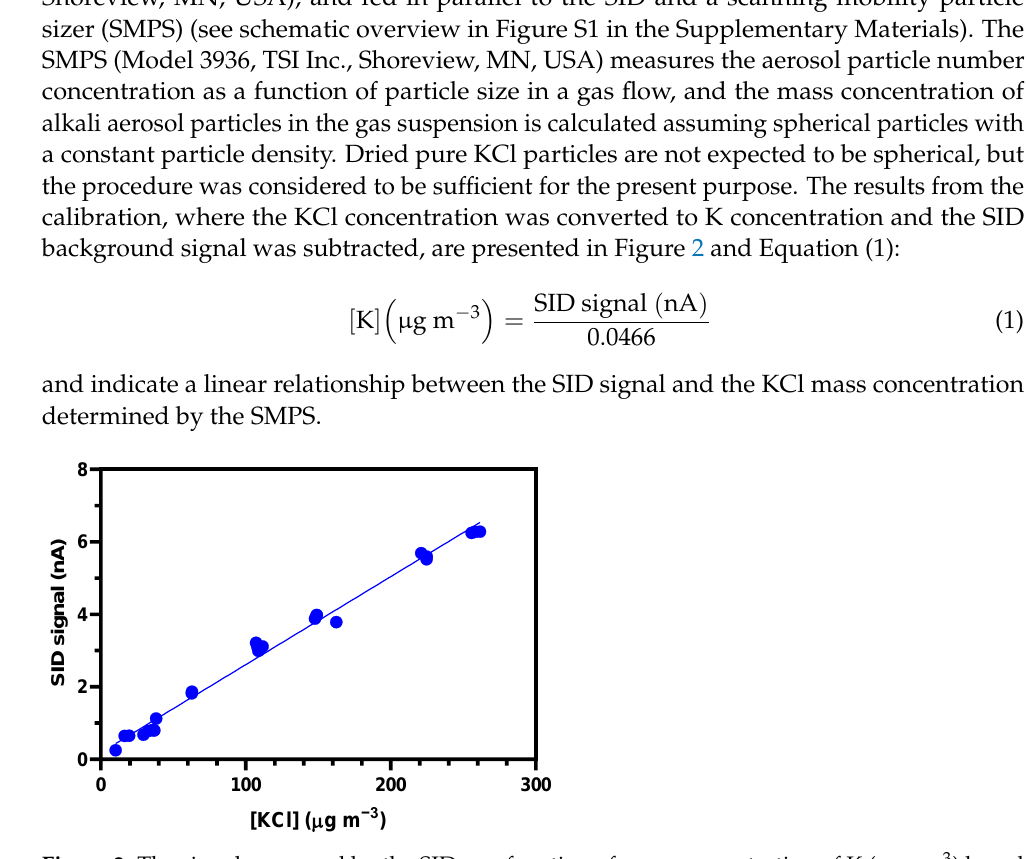
Figure 2. The signal measured by the SID as a function of mass concentration of K ( µ g m − 3 ) based on the concentration of KCl aerosol particles determined by a SMPS. The calibration experiments were carried out using a continuous flow of KCl aerosol particles generated with an aerosol atomizer (see the text for details).